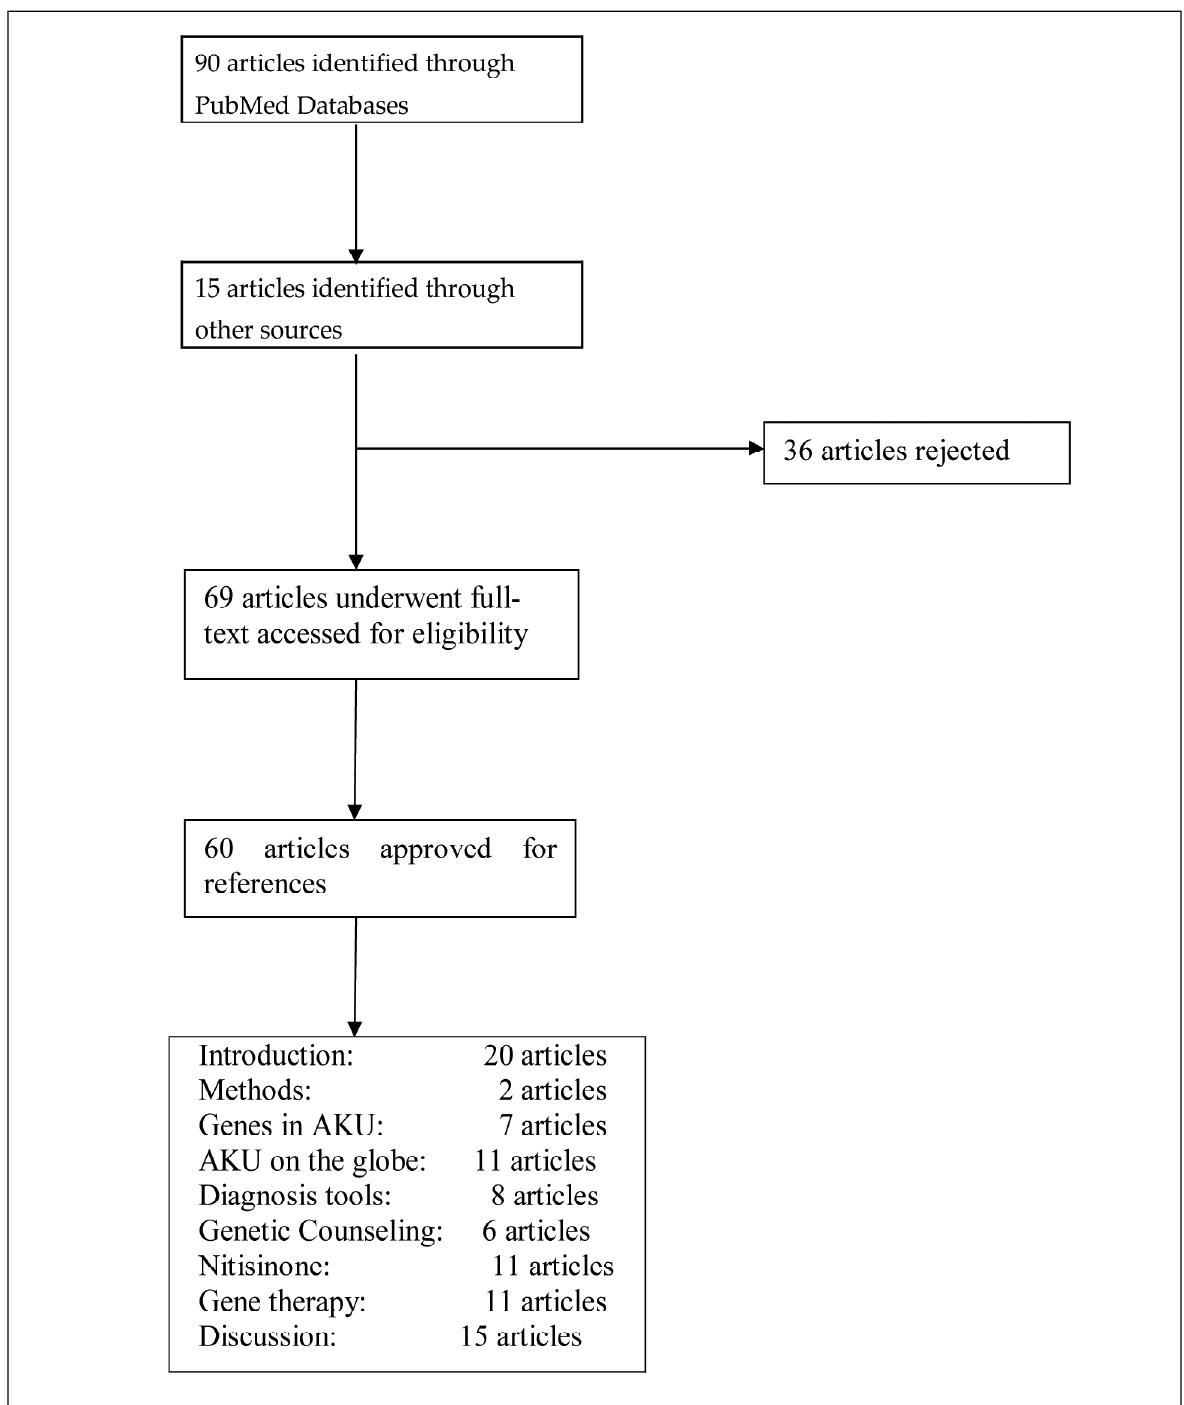
Figure 1: A flowchart articles selected in the systematic